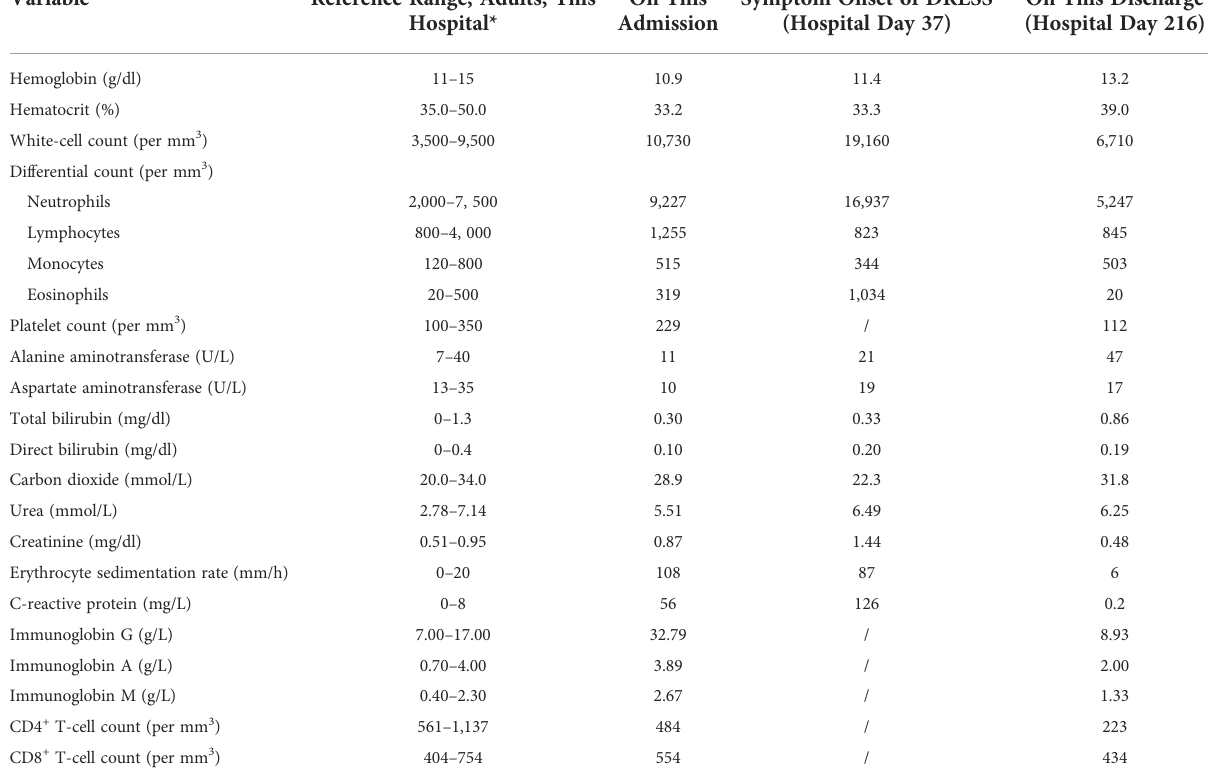
TABLE 1 Laboratory